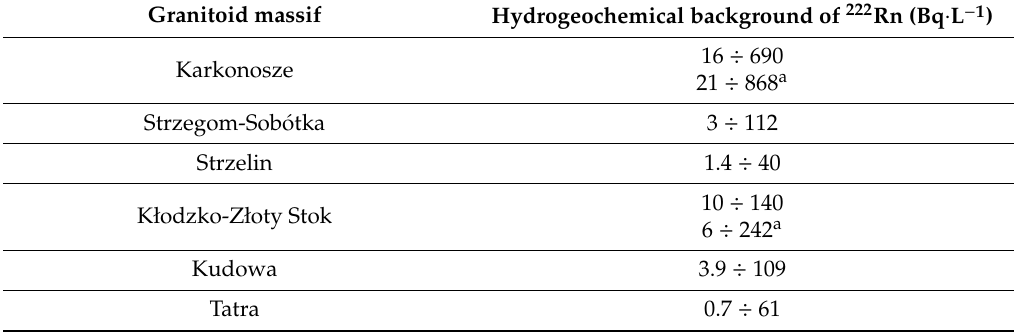
Table 3. Ranges of hydrogeochemical background of 222 Rn in groundwaters from granitoid massifs of Poland.